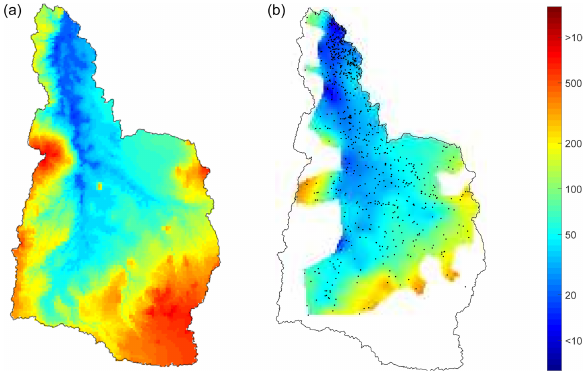
Figure 12. (a) NWT water table elevation and (b) the interpolated surface of water table elevation from ground observation in the Waipa catchment (Rawlinson, 2014). All elevations are in ma.s.l. Ground observations used for the interpolated surface are shown in black